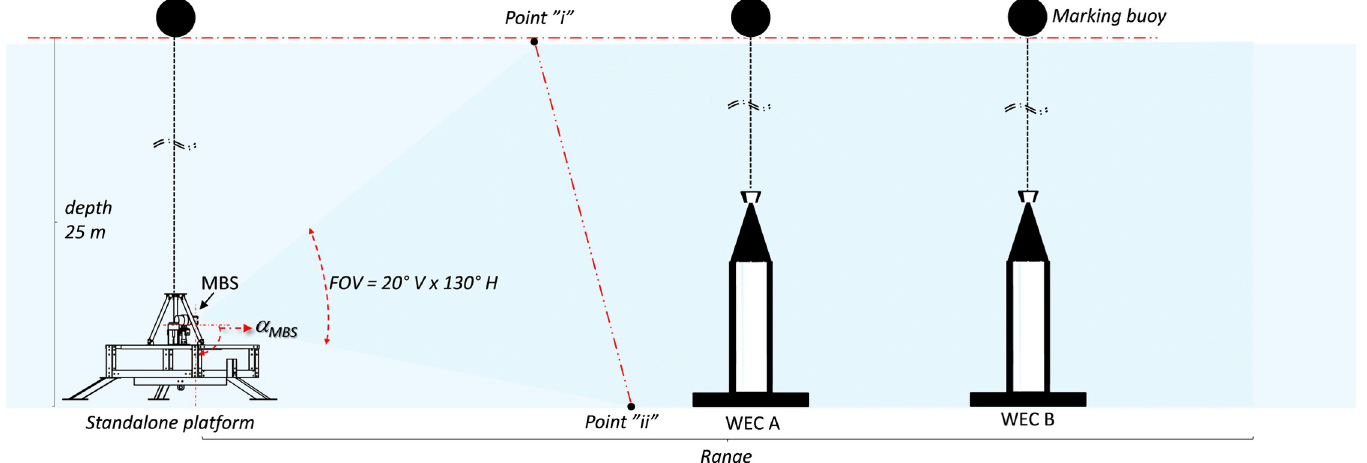
Fig 2. The standalone monitoring platform: (a) The multibeam imaging sonar (MBS) together with split beam sonar (SBS), the three boxes contain batteries, controllers and an on-board computer; (b) The standalone platform deployed at the seabed.